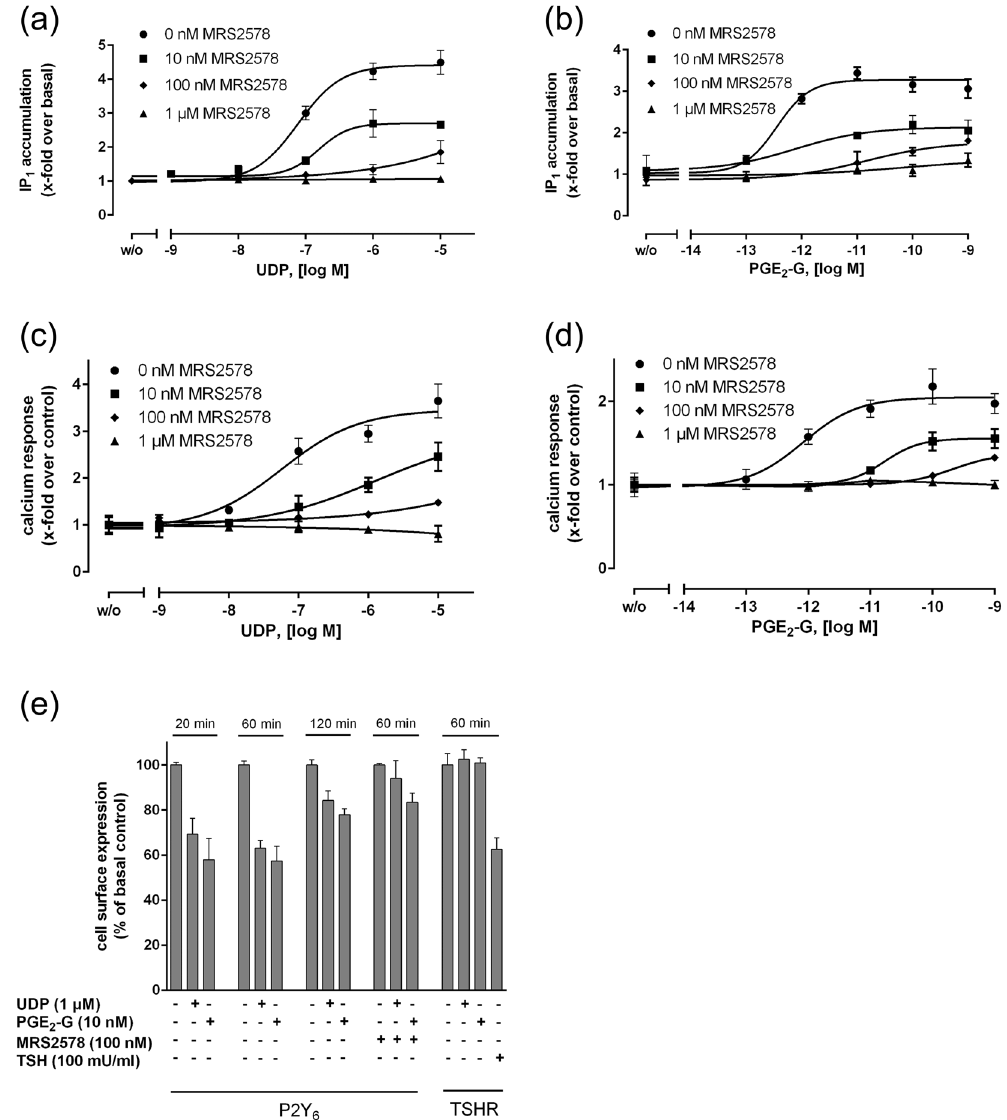
Figure 5. UDP- and PGE2-G-induced signaling can be blocked by the P2Y6 antagonist MRS2578. HEK293 cells were stably transfected with P2RY6, and the IP 1 accumulation assay and measurement of Ca 2 + release was performed as described under Methods . Concentration-response curves of UDP ( a , c ) and PGE 2 -G ( b , d ) were performed in the absence and presence of different concentrations of the antagonist MRS2578 in 1% DMSO. EC 50 values for UDP and PGE 2 -G in IP 1 accumulation assay were 77.3 ± 3.4 nM and 0.3 ± 0.02 pM, respectively, and 57.1 ± 2.5 nM and 0.8 ± 0.08 pM in Ca 2 + mobilization assay. Data are means ± SEM of three independent experiments, each performed in triplicate. ( e ) HEK293 cells were transiently transfected with hP2RY6 and the HA-tagged human TSH receptor (TSHR) and the receptor expression levels were measured by cell surface ELISA (see Methods ). Both, UDP and PGE 2 -G induced a time-dependent internalization of the P2Y 6 whereas both compounds had no effect on the cell surface expression of the TSH receptor. The TSH receptor was stimulated with bovine TSH (100 mU/ml). The non-specific antibody binding to empty vector-transfected cells revealed an OD 492 nm of 0.01 ± 0.002. Data are given as mean ± SEM of three independent experiments each performed in